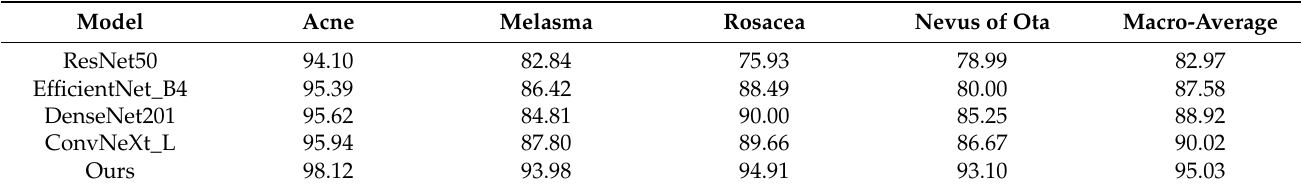
Table 4. The f1-score of each model on our private dataset, the unit is %.